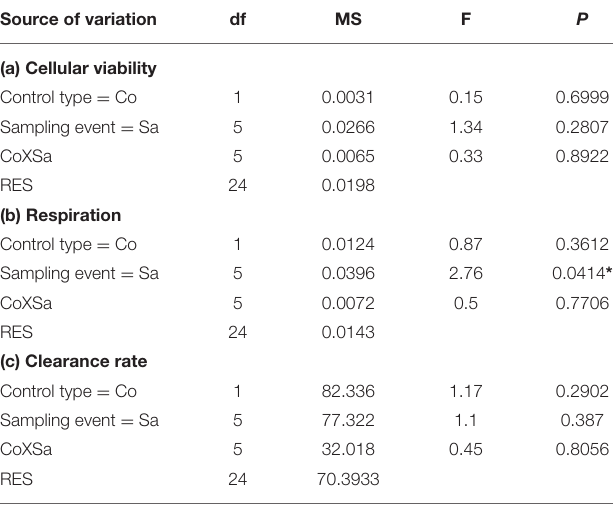
TABLE 5 | Analysis of control treatments sampled over the duration of the experiment for (a) cellular viability (optical density g − 1 haemocyte protein) data,